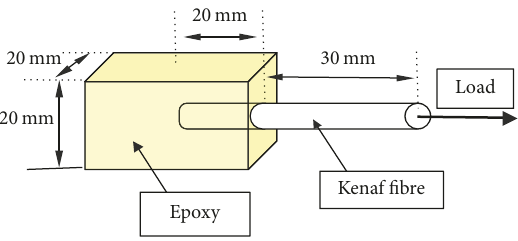
Figure 1: Schematic drawing of pull-out samples.